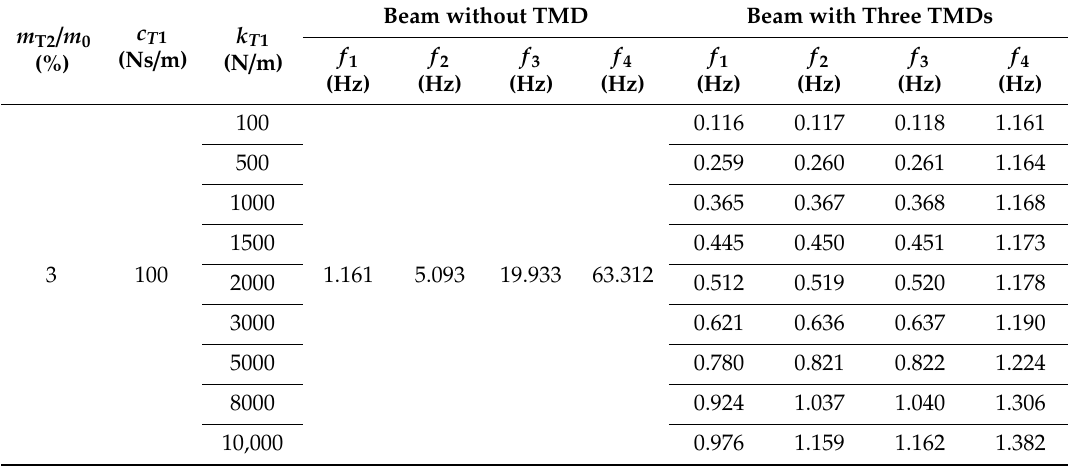
Table 6. Variation of the first natural frequencies as a function of k T